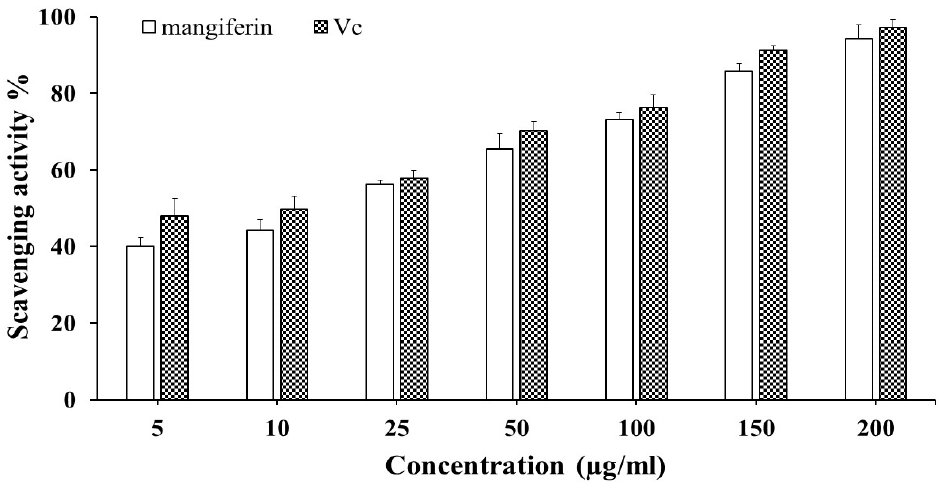
Figure 2. DPPH radical scavenging activity at different concentrations (5–200 µ g/mL) of mangiferin and a positive control, vitamin C. Data are expressed as means ± SD, n = 3, and are displayed as a percentage of the control sample.